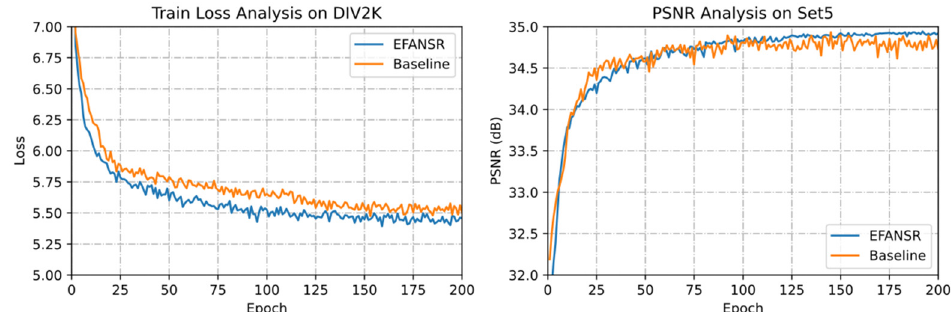
Figure 7. Convergence analysis of EFANSR (blue curves) and Baseline (orange curves) with 3 × . On the left is the training loss curve on the DIV2K dataset, and on the right is the peak signal-to-noise ratio (PSNR) curve on the Set5 dataset.